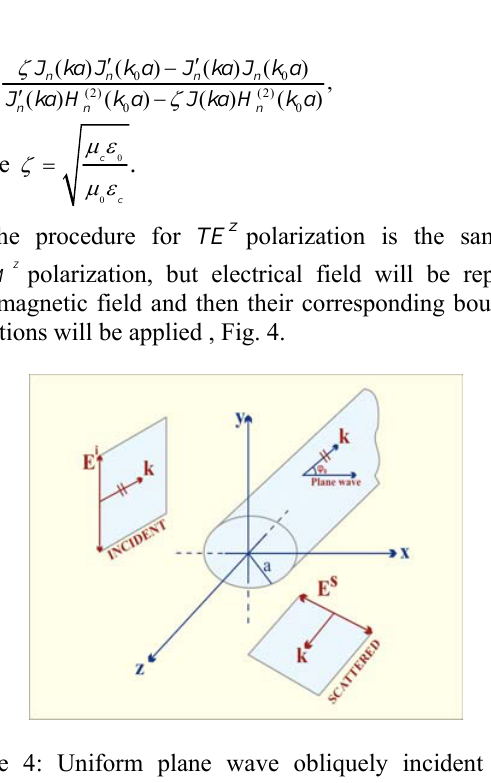
Figure 4: Uniform plane wave obliquely incident on a Metamaterials cylinder: z TE polarization.